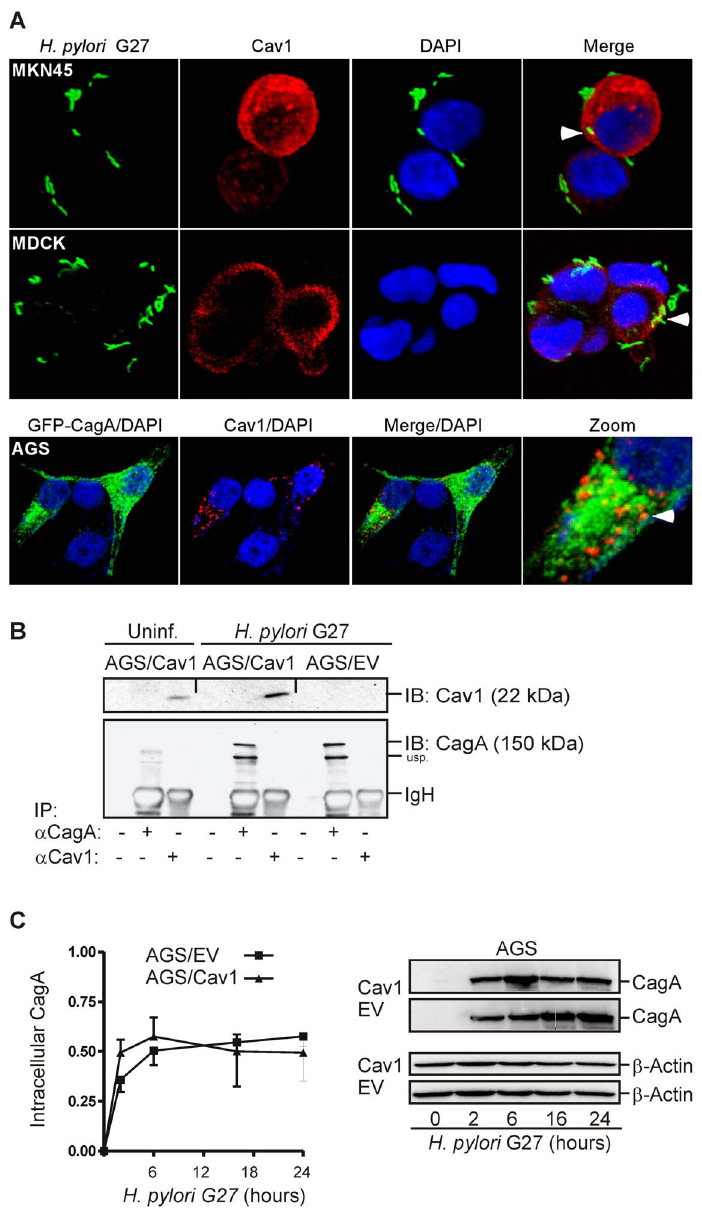
with GFP-CagA expression plasmid, followed by staining for confocal immunofluorescence microscopy; green= H. pylori /GFP-CagA, red=Cav1, blue=nuclei. Magnification 6 630. Occasional colocalizations appear in yellow. (B) Cav1 does not directly interact with CagA. Cells were infected as in (A) for 16 h (MOI=100), and cell lysates were incubated with rabbit polyclonal CagA and Cav1 antisera. Precipitated proteins were detected by WB. Representative CoIP experiments are shown. (C) Gentamycin protection assay. Cav1 has no impact on injection of CagA into the host cell. AGS clones were infected with H. pylori G27 (MOI=500) for 2 to 24 h, extensively washed with antibiotics, and intracellular CagA was determined by WB. Representative results are shown next to the quantitative analyses. O.D. values from bands in gels were calculated as mean 6 S.E. (n=3